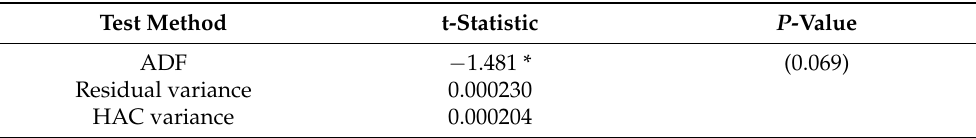
Table 6. Kao Residual Cointegration